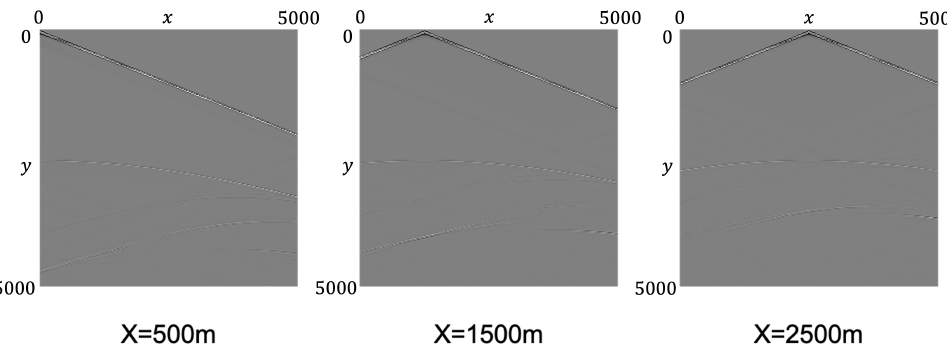
Figure 8. Seismic waveforms at different shot